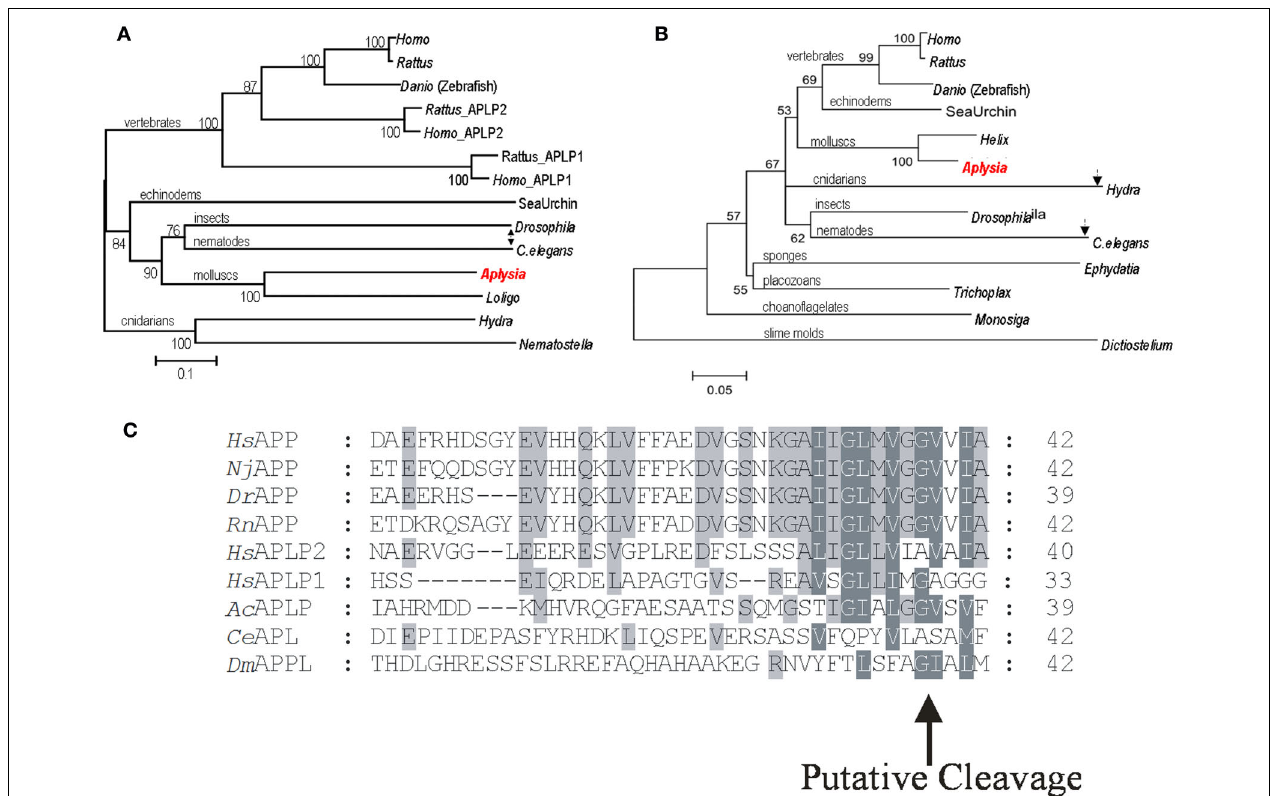
FIGURE 3 | Phylogeny of Alzheimer’s disease associated proteins. (A) The phylogenetic tree for amyloid precursor protein. (B) Phylogenetic Tree for Presenilins. The position of Aplysia homologs is marked by red while arrows indicate the position and branch length for Drosophila and C. elegans homologs as more derived proteins (see text for details). (C) Predicted Aplysia amyloid-like B peptide and the conservation of a putative cleavage site. Aplysia amyloid-like B peptide shares higher identity to the human APP, BAA22264, APLP1, NP_ 005157.1 and APLP2, NP_001633.1, including the putative cleavage site by γ - secretase, than C. elegans , AAK68242 or Drosophila , NP_476626.2. Shark, Narke japonica BAA24230.1, zebrafi sh, Danio rerio AAK64495, and rat, Rattus norvegicus AAH62082.1 are included. Tree construction and sequence analysis . The phylogenetic tree was generated using default parameters and 10,000 iterations of the maximum likelihood algorithm implemented in the program TREE-PUZZLE (http://www.tree-puzzle.de). The initial multiple alignment was done using ClustalX (Thompson et al., 1997; Jeanmougin et al., 1998) with default parameters; all gaps were removed manually in GeneDoc (Nicholas et